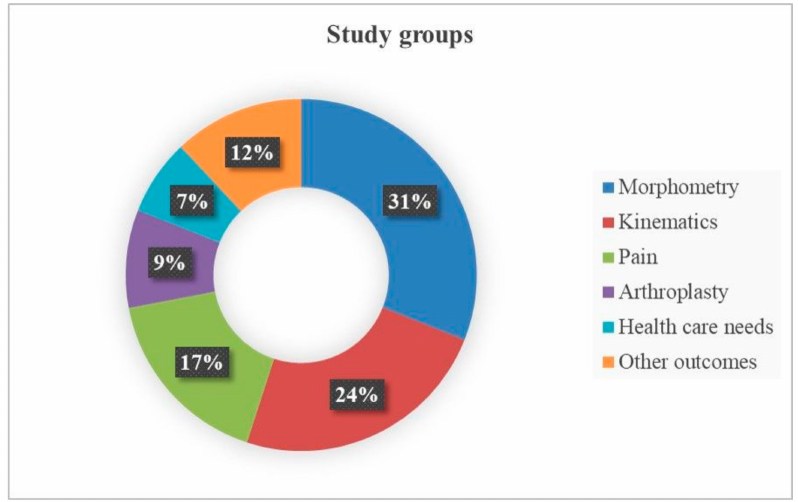
Figure 3. Diagram of percentages of included studies grouped by clinical endpoints